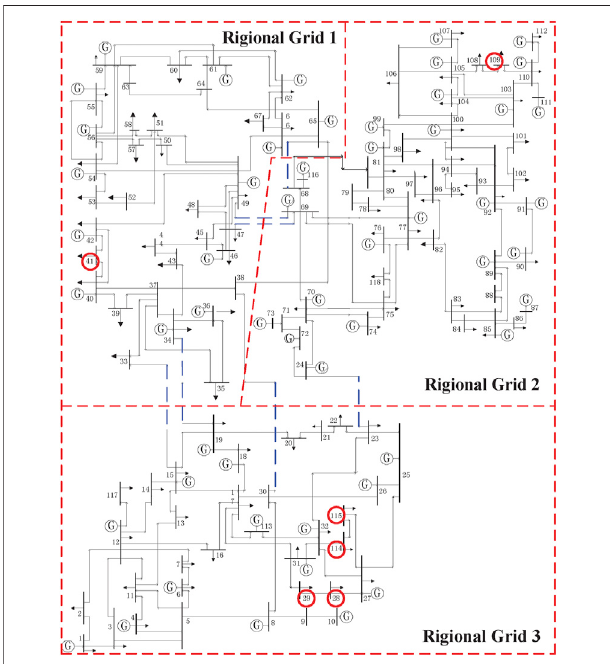
FIGURE 6 | IEEE 118-bus system partition diagram.